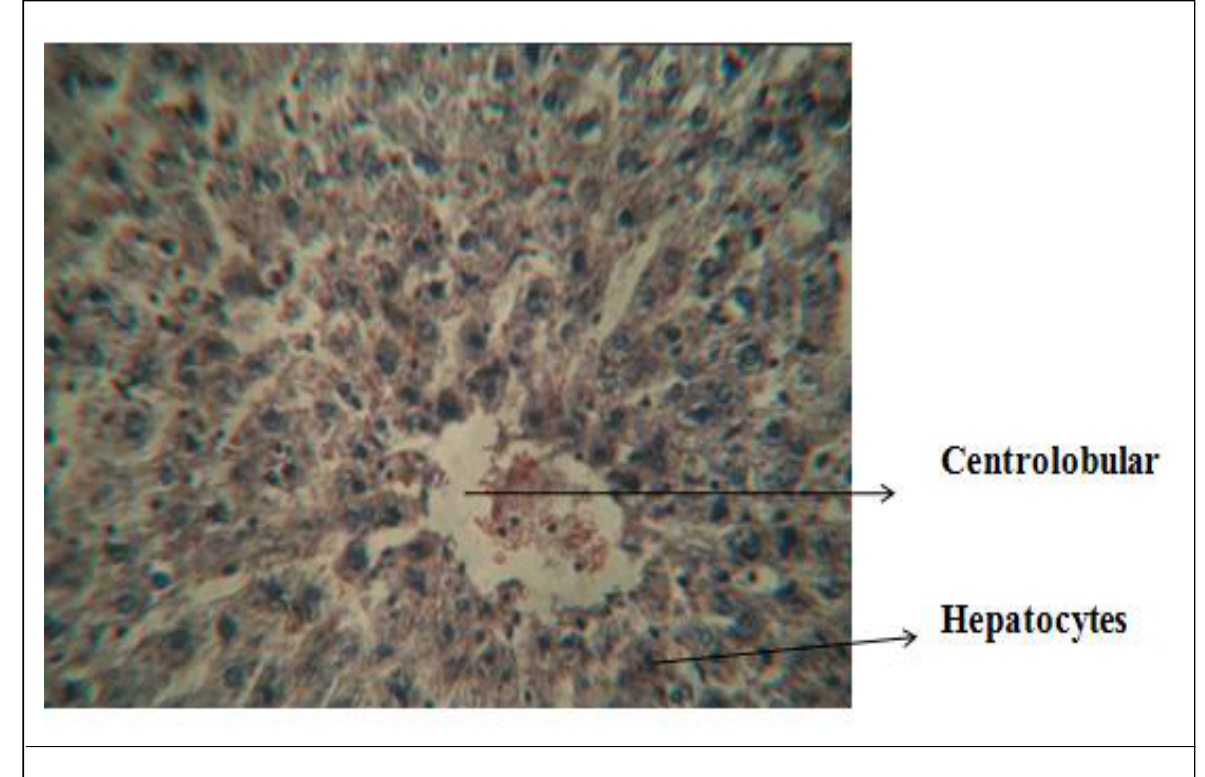
Plate 5: Shows the micrograph of rats in group Group 5 (Paraquate intoxication, + 800 mg/ml guava extract